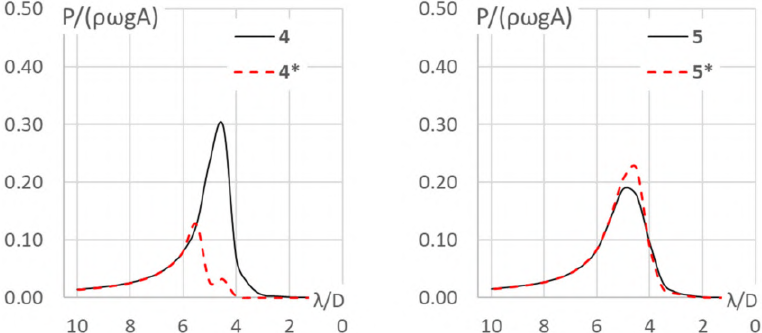
Figure 10. Power absorbed with PTO damping applied. “1–5” and “1*–5*” denote full wave field and local frequency truncated wave field at bodies 1 to 5, respectively. P , ρ , ω , g , and A , stand for the power absorbed, the fluid density, the angular frequency, the standard gravity acceleration, and the local incoming undisturbed (full wave field) wave amplitude at each body,